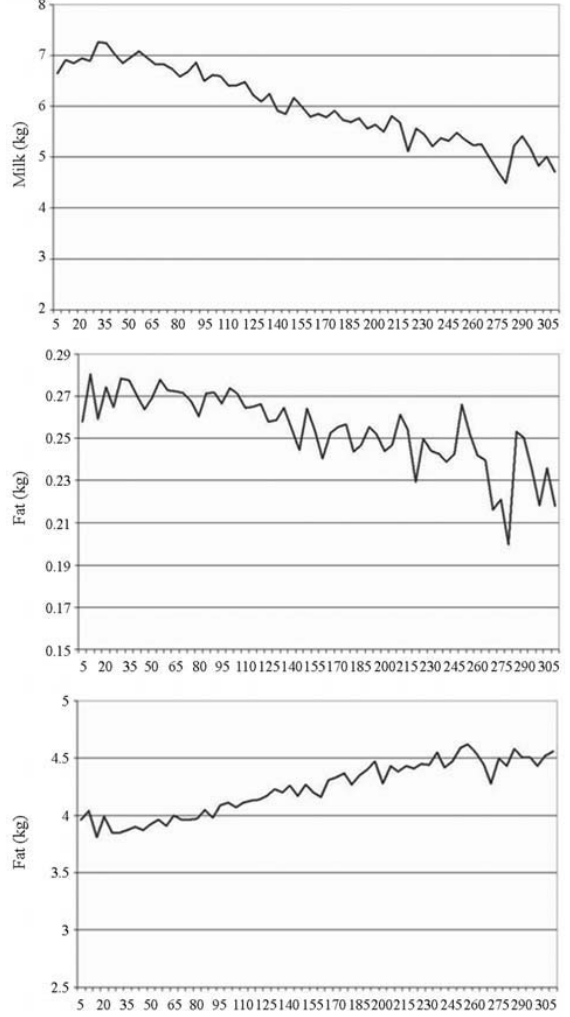
Figure 1 - Effects of year of calving on milk yield (MY), fat yield (FY) and fat percentage (FP) of crossbred Holstein-Zebu cows.